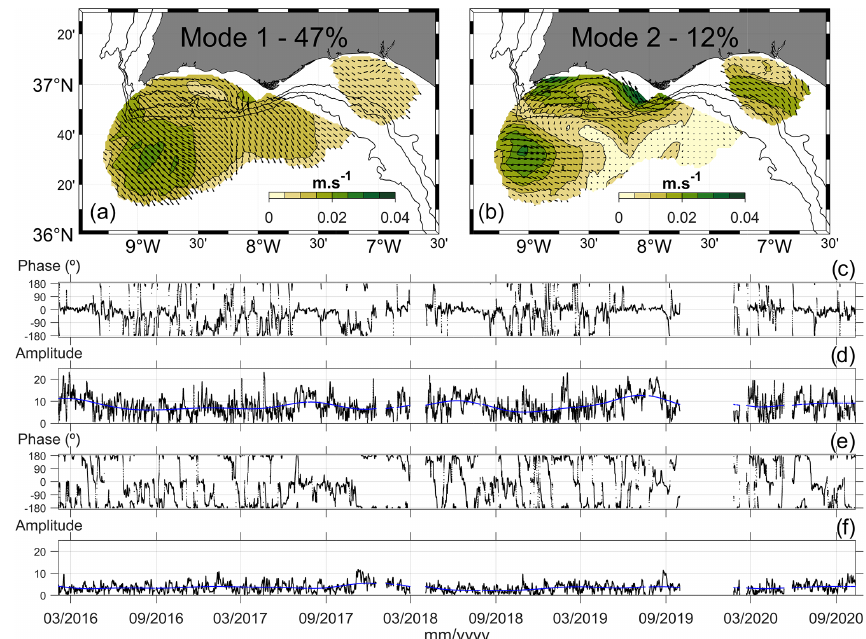
Figure 7. Results of the complex EOF analyses: spatial modes 1 (a) and 2 (b) and temporal modes 1 ( c : phase, d : amplitude) and 2 ( e : phase, f : amplitude). The reconstructed velocity for each mode corresponds to the local spatial value multiplied by the dimensionless amplitude and rotated respective phase angle. For clarity, arrows are represented every three grid nodes. The ticks on the x axes indicate the beginning of spring and autumn. The blue line in (d) and (f) represents the low-pass-filtered time series with a cut-off period of 6 months.